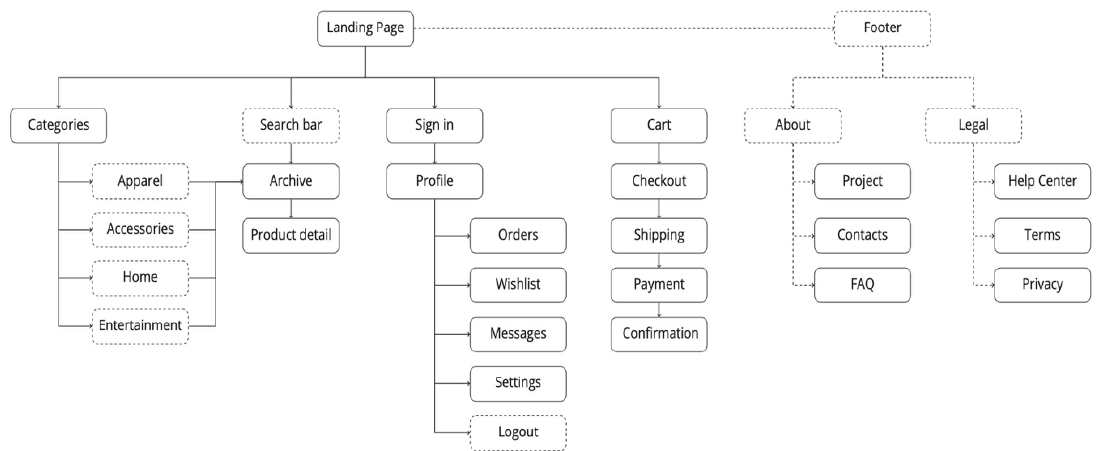
Figure 2. Information Architecture (IA) for buyers’ prototype. Self-source, 2020.